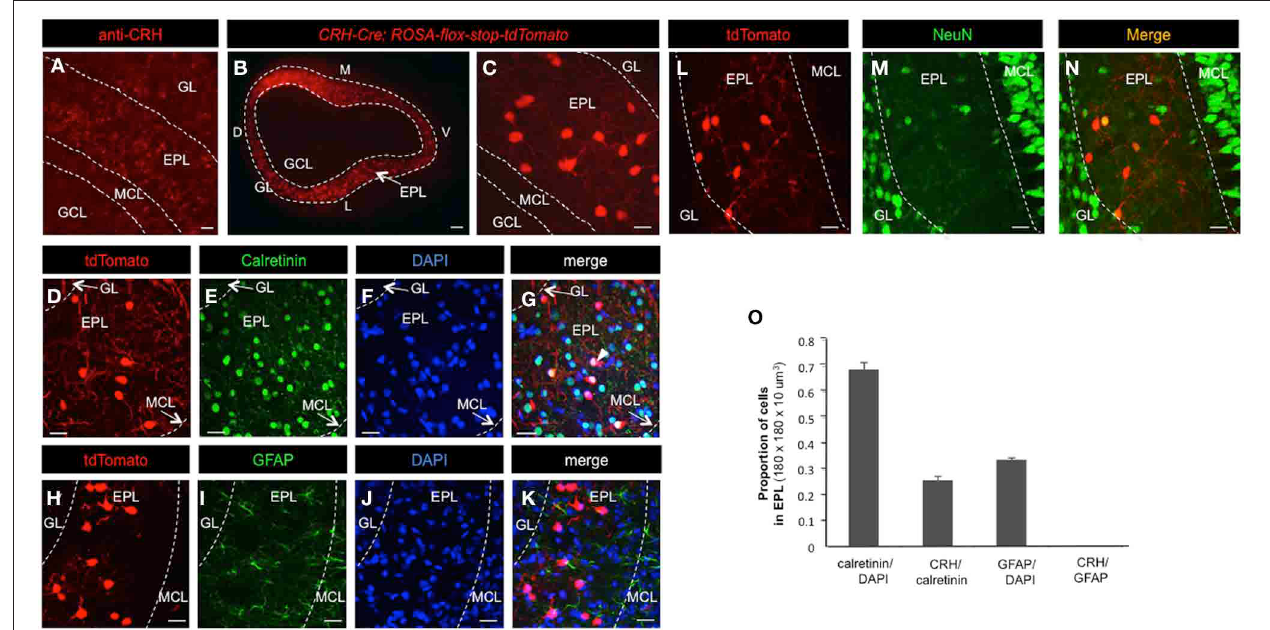
in CRH-Cre; Rosa-lox-stop-lox-tdTomato mice . Scale bar, 20 μ m. (O) The proportion of calretinin + cells in all EPL cells, CRH + neurons in all calretinin + interneurons, GFAP + cells in all EPL cells, and CRH + neurons in all GFAP + cells. N = 3 mice, and 20–30 sections each. Error bars represent SEM. GL, glomerular layer; EPL, external plexiform layer; MCL, mitral cell layer; GCL, granule cell layer; D, dorsal; V, ventral; M, medial; L, lateral. All the images are from coronal sections. In panels ( B,C,D,H, and L ), the red fluorescence is directly from tdTomato without antibody